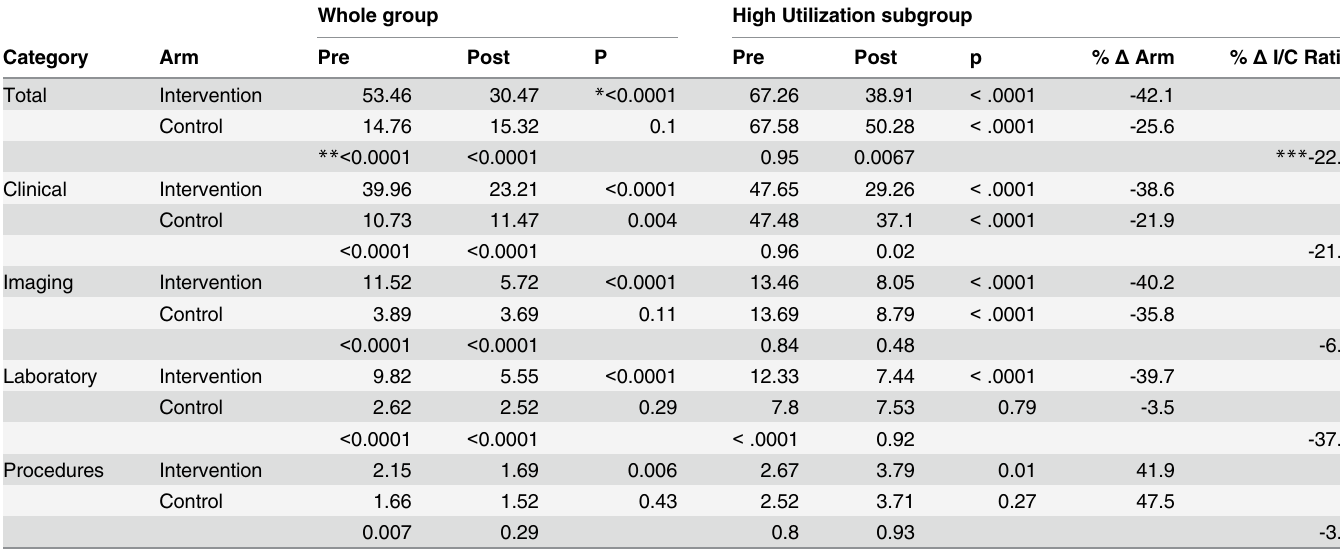
Table 3. Functional Category: Utilization Rate (Pre- vs. Post — Intervention) by Average Billable Encounters/year. Whole group High Utilization subgroup Category